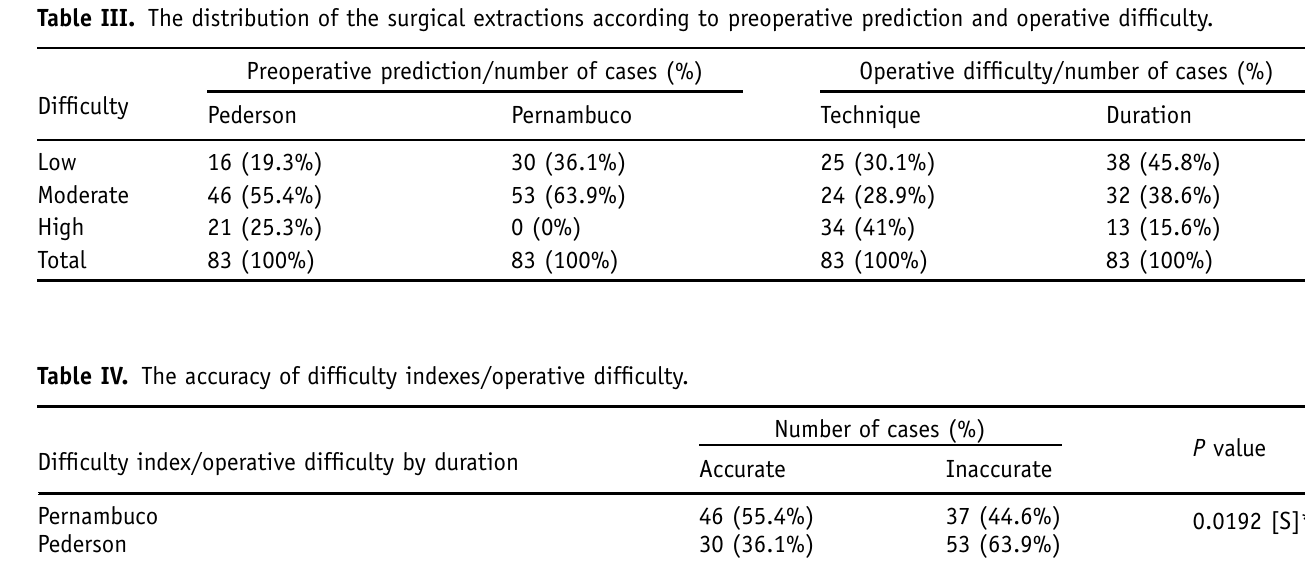
Table III. The distribution of the surgical extractions according to preoperative prediction and operative dif fi culty.